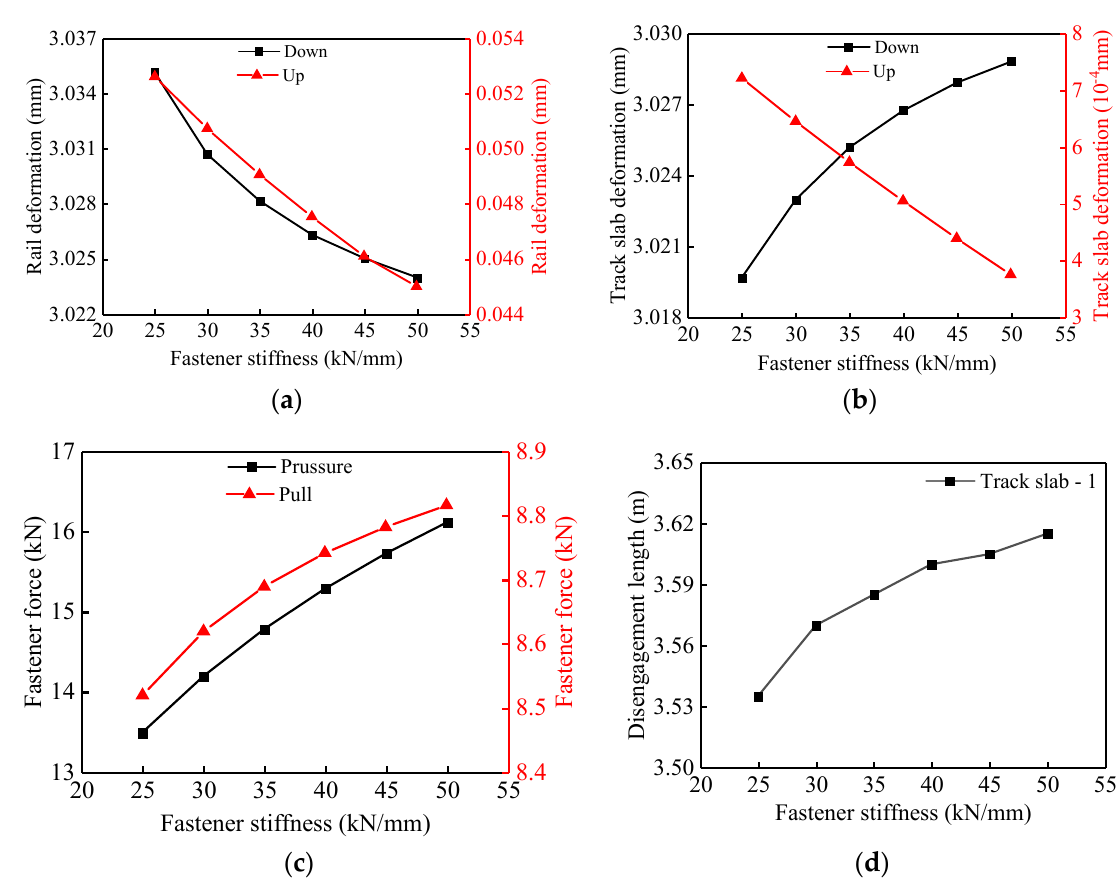
Figure 11. Effects of different fastener vertical stiffness on track structures: ( a ) variation of rail deformation; ( b ) variation of